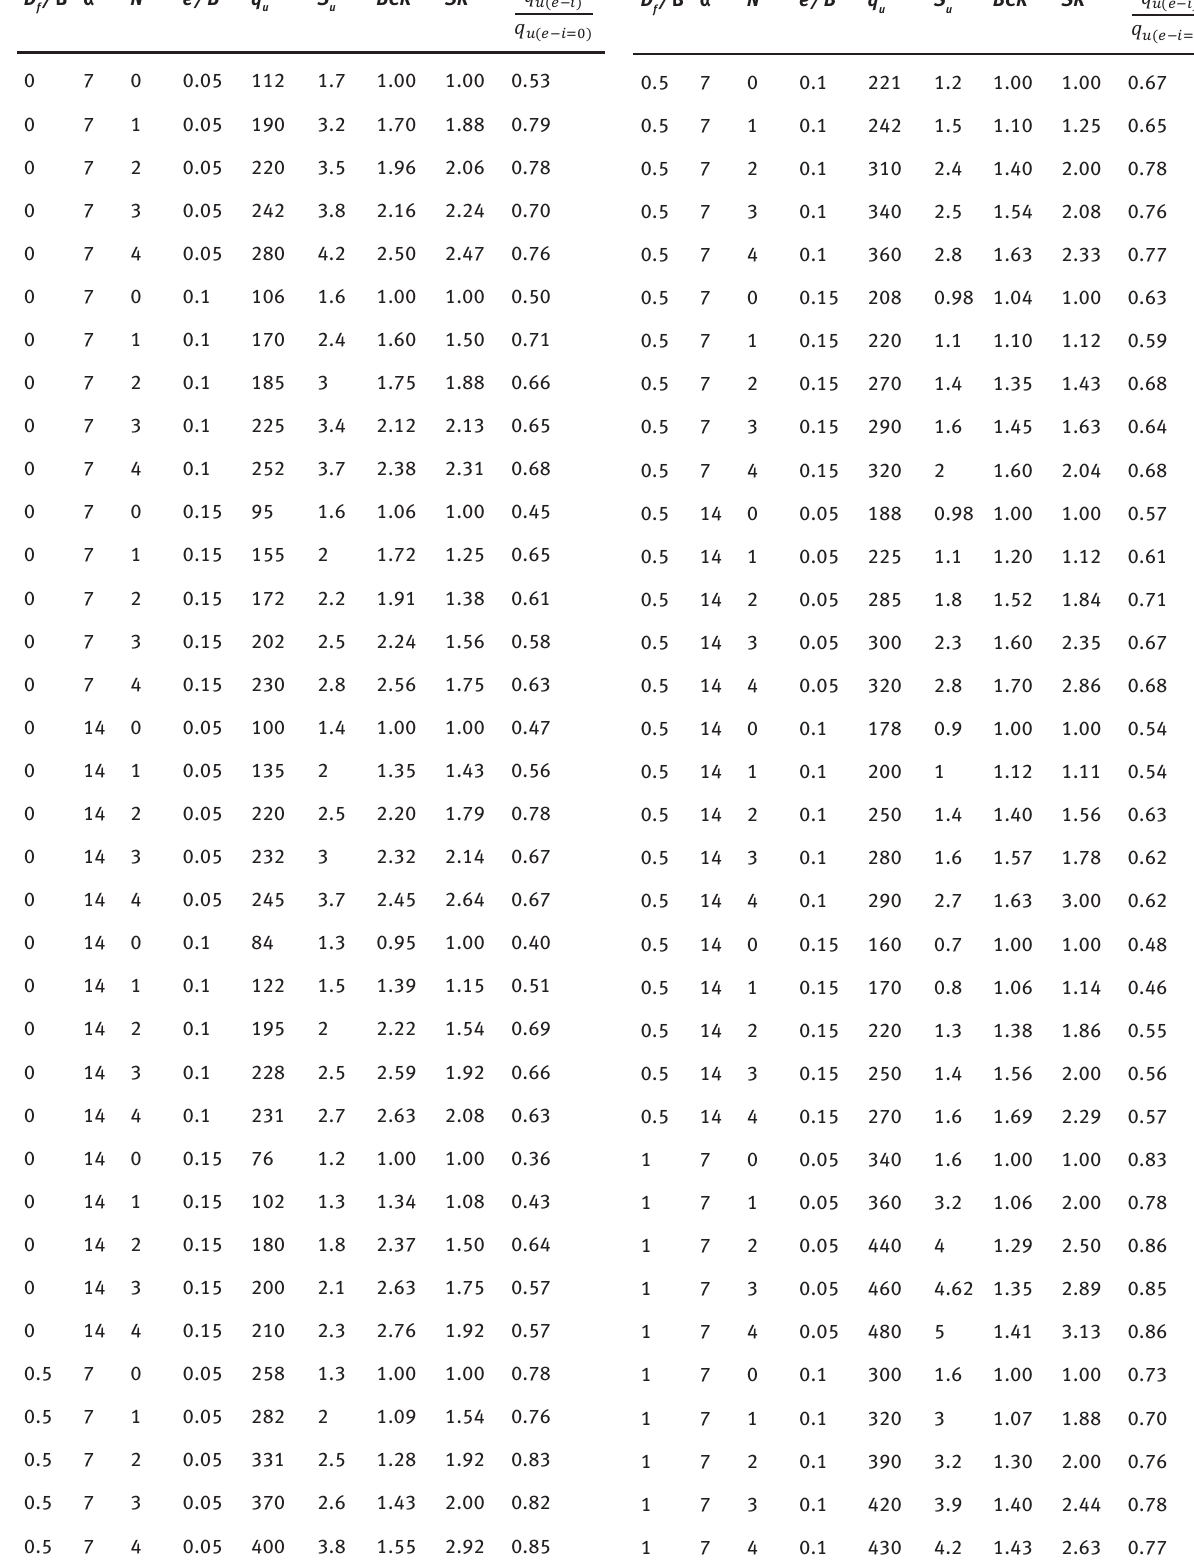
Table 5: Results of eccentrically inclined, loaded ( a ̊, e / L ) rectangular footing in unreinforced and reinforced sand